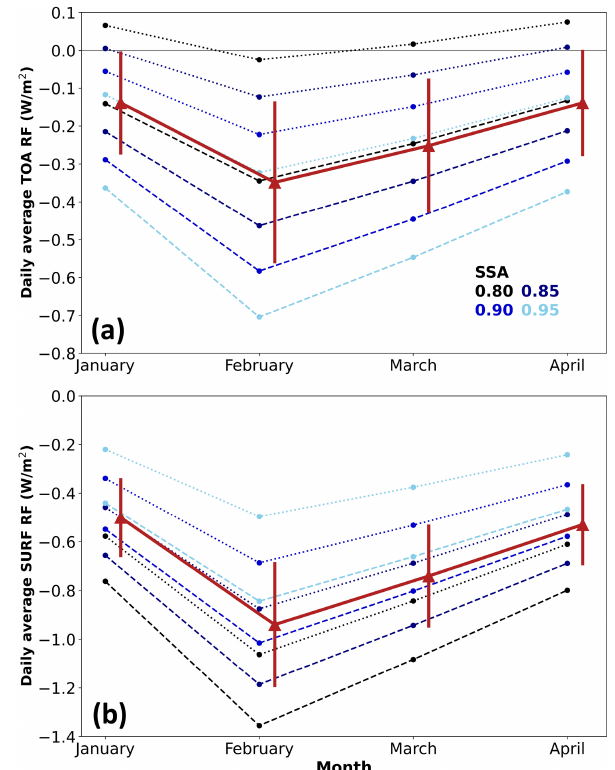
Figure 6. Time series, from January to April 2020, of the monthly mean area-weighted global-equivalent TOA (a) and surface RF ( b ; based on equinox-equivalent daily-average RF), for the UTLS per- turbation of Australian fires in 2019–2020. Different shades of blue dots and lines are for different SSA values – the darker the shade the smaller the SSA. Dashed and dotted blue lines are for g val- ues of 0.5 and 0.7, respectively. The red triangles and thick solid lines represent the mean TOA and surface global-equivalent RF, av- eraged over the whole SSA and g scenarios. Error bars represent their